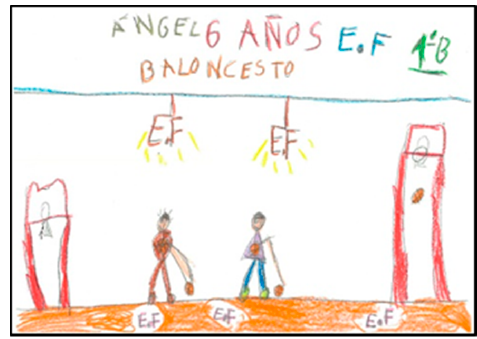
Figure 5. Human body proportion. Ángel. 1°B.